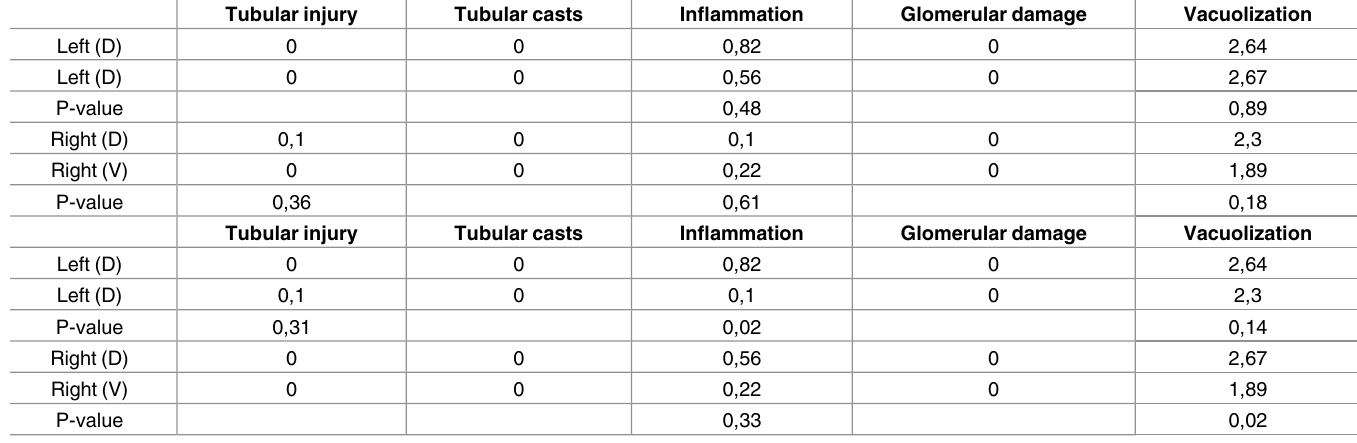
Table 2. Histological grades. The numbers are expressed as a mean for all animals in the group. In the top table, the Danegaptide treated and the vehicle animals are compared. In the bottom table, the left, injured kidney is compared to the right, contralateral kidney. Tubular injury Glomerular